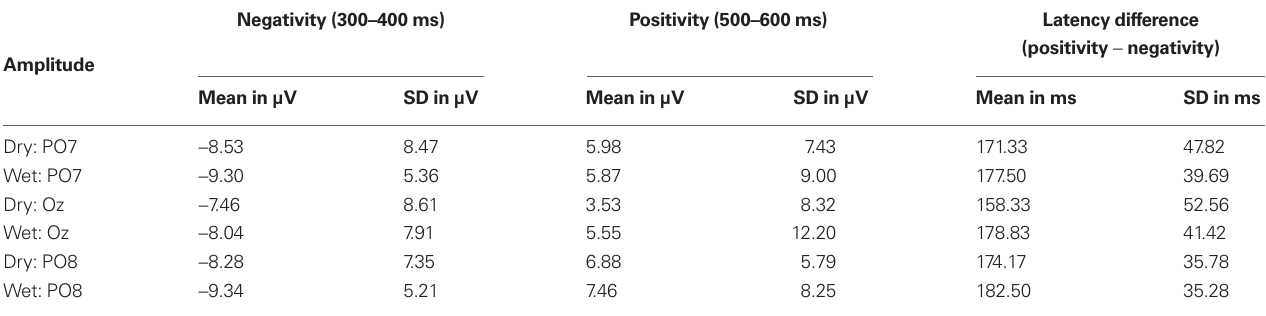
Table 1 | Event-related potential results. Mean values and SD for peak amplitudes and latency differences for the negativity and positivity.